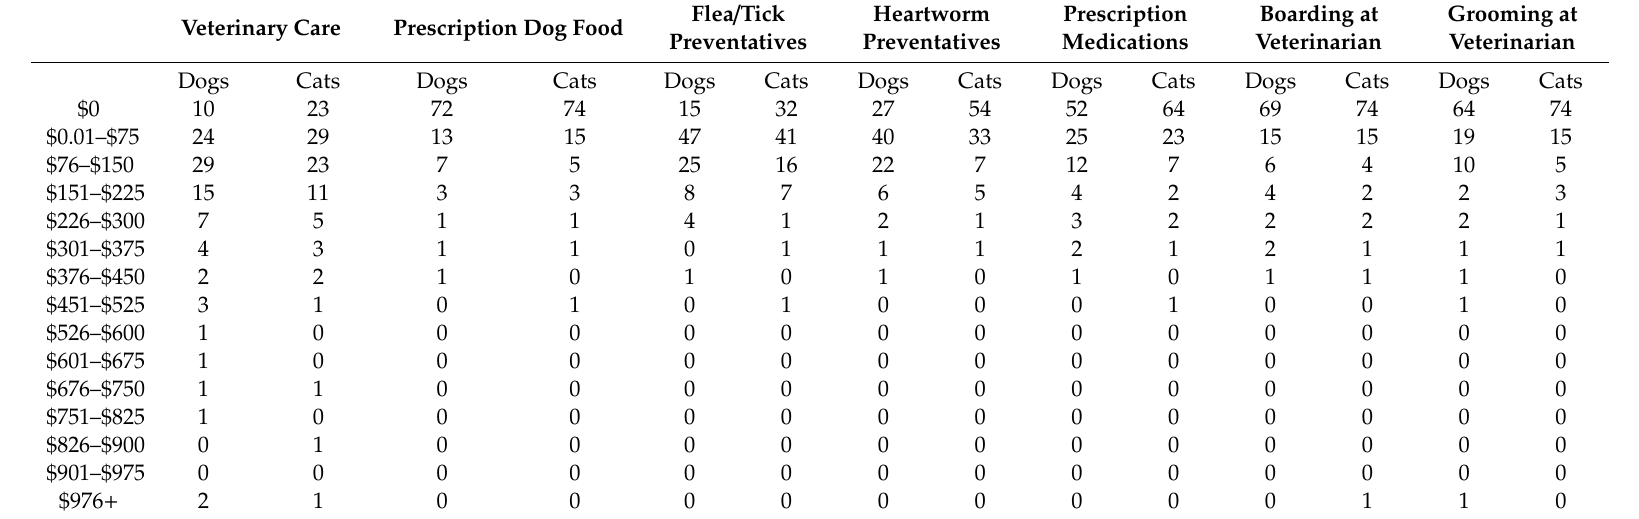
Table 8. Annual pet owner spending on veterinary related items per pet, percentage of dog (n = 480) and cat (n = 332) owners.